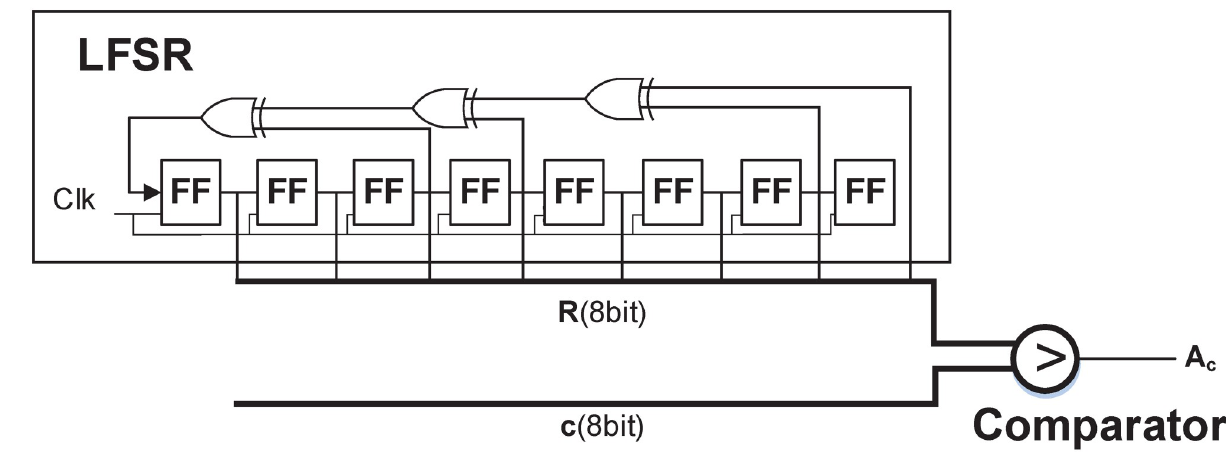
Fig 1. Stochastic number generator